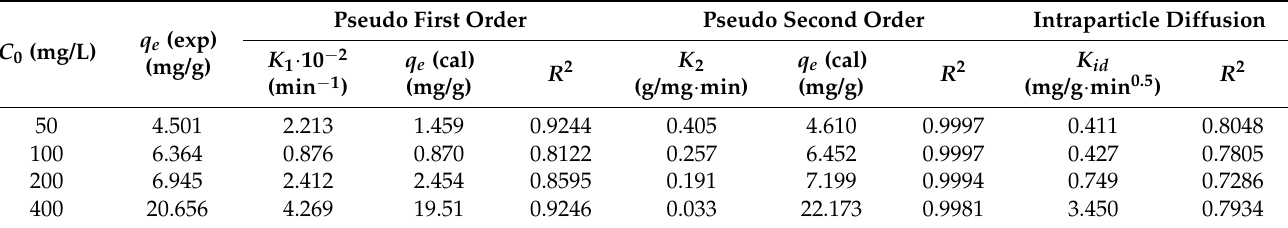
Table 4. The kinetic parameters of the